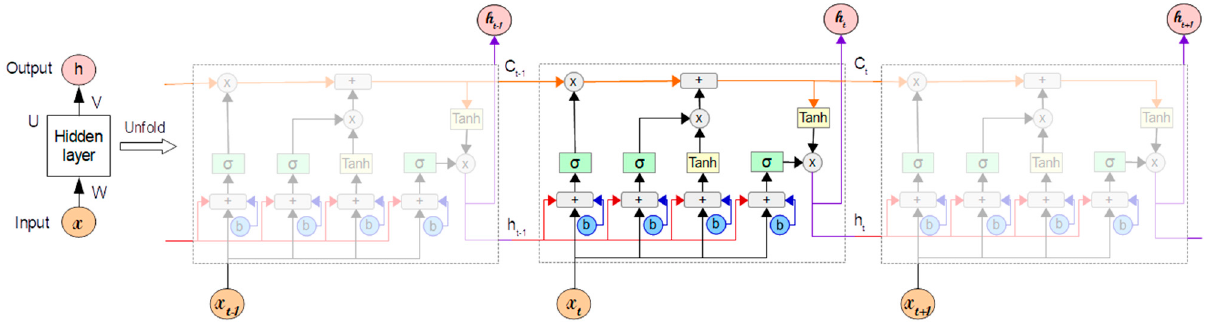
Figure 1. Long Short-Term Memory neural network structure.